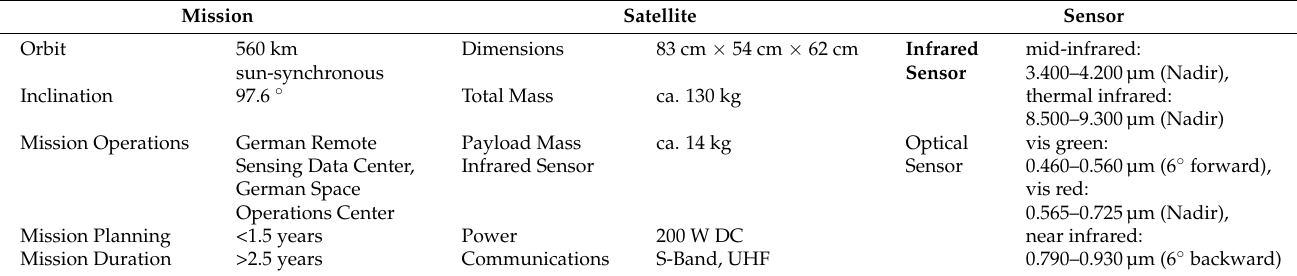
Table 1. Overview of the FireBIRD-mission specifications ([7,19],